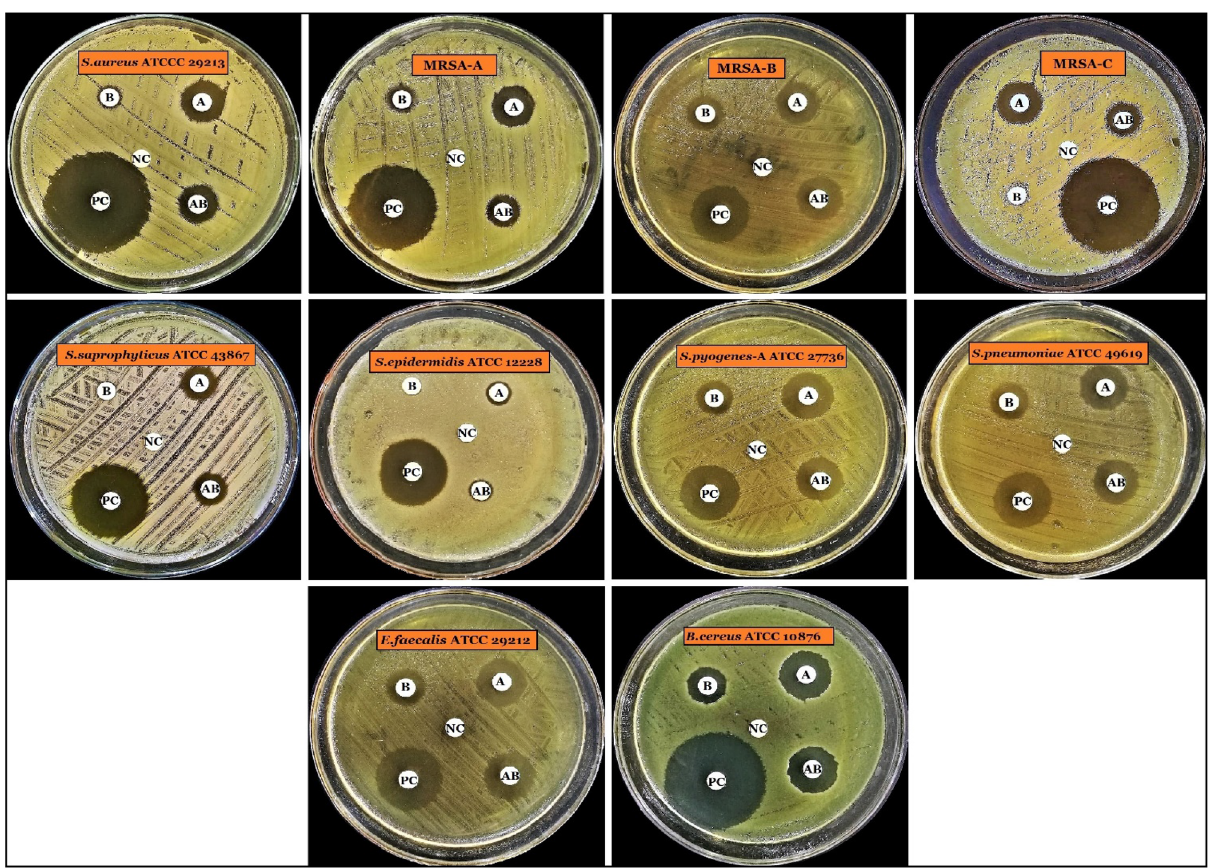
Figure 8. Primary antimicrobial activity of isolated actinomycins X 2 and D. A = Actinomycin X 2 (5 µg/disc), B = Actinomycin D (5 µg/disc), AB = Actinomycins-complex (X 2 + D; 1:1 w/w; 5 µg/disc), PC Positive control/